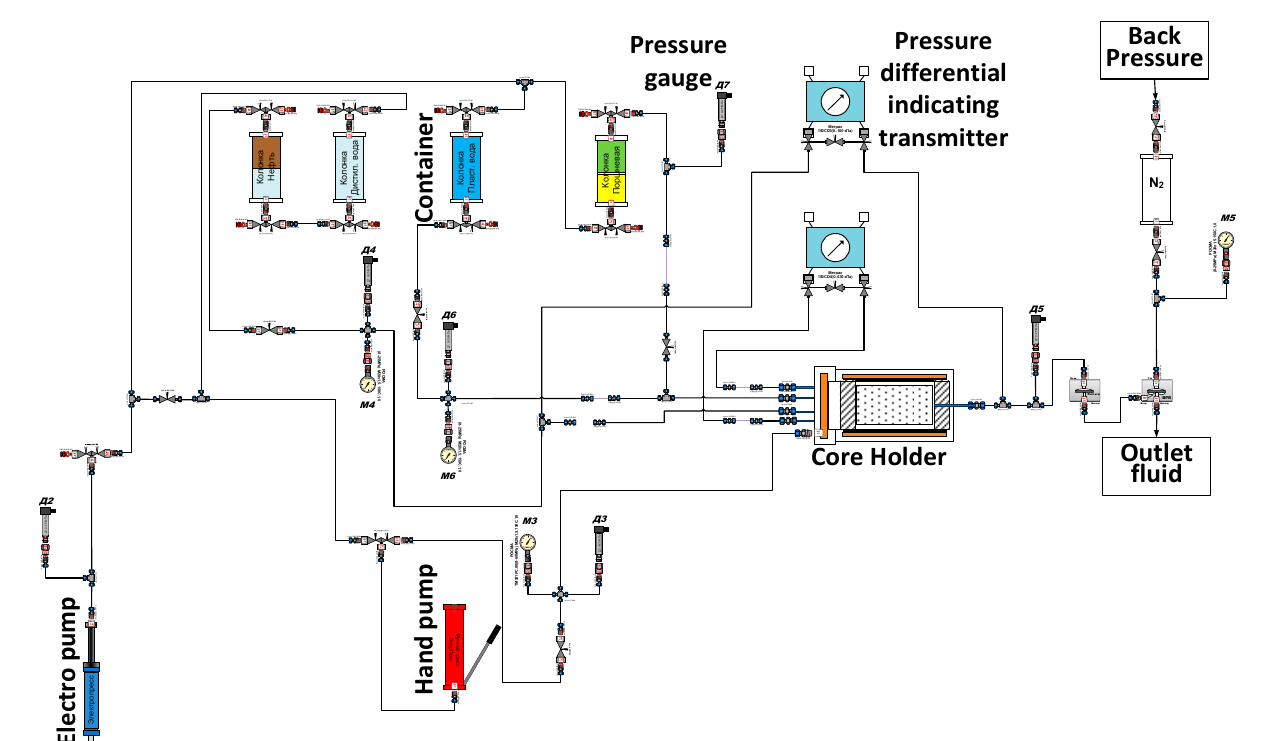
Figure 4. Hydraulic diagram of the Tech-ViP unit used for testing polymer compositions.